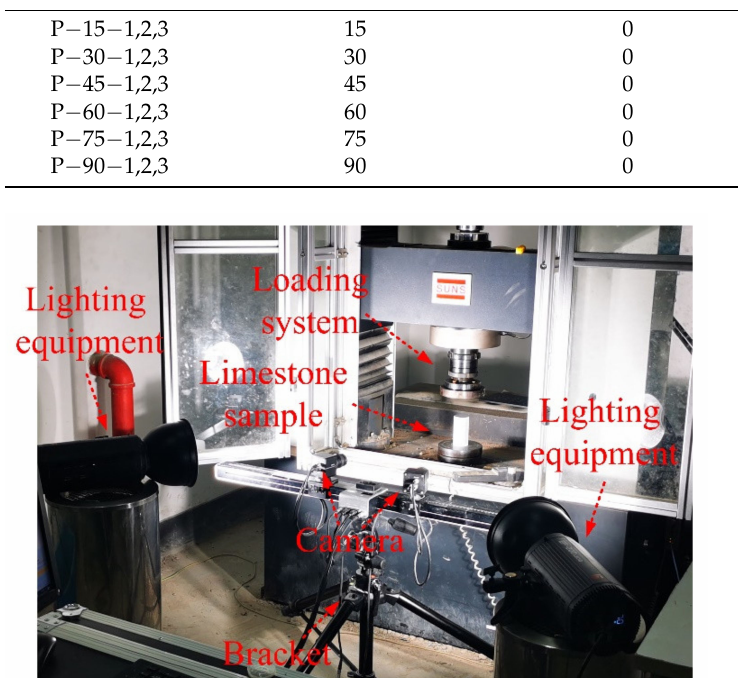
Figure 3. Test site image.